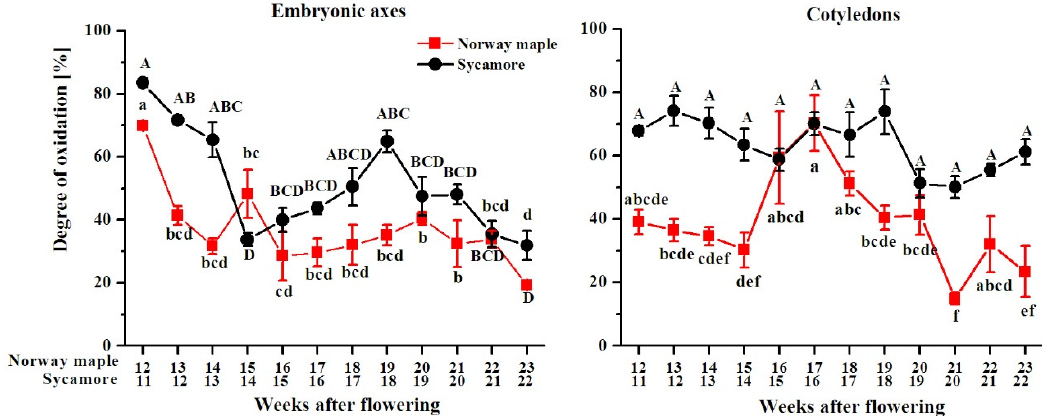
Figure 13. Changes in the degree of oxidation of glutathione in the embryonic axes and cotyledons of developing seeds of Norway maple (squares) and sycamore (circles) collected during the 11th–23rd weeks after flowering. Data are the means of three independent replicates ± the standard error. Statistically significant differences are indicated with different letters (one-way ANOVA, followed by Tukey’s test at p < 0.05). The capital letters refer to sycamore.